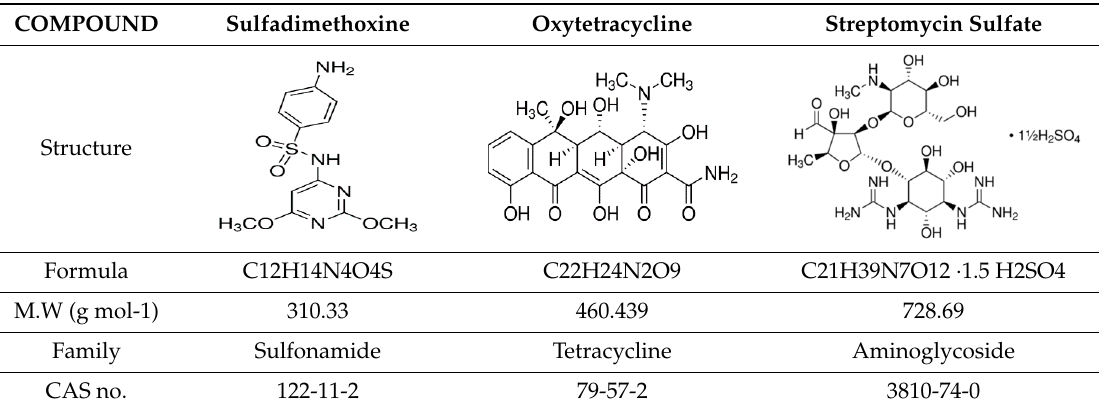
Supplementary Materials: The following are available online at www.mdpi.com/xxx/s1, Table S1: Properties of veterinary antibiotics used in the study. Table A1. Properties of veterinary antibiotics used in the study.